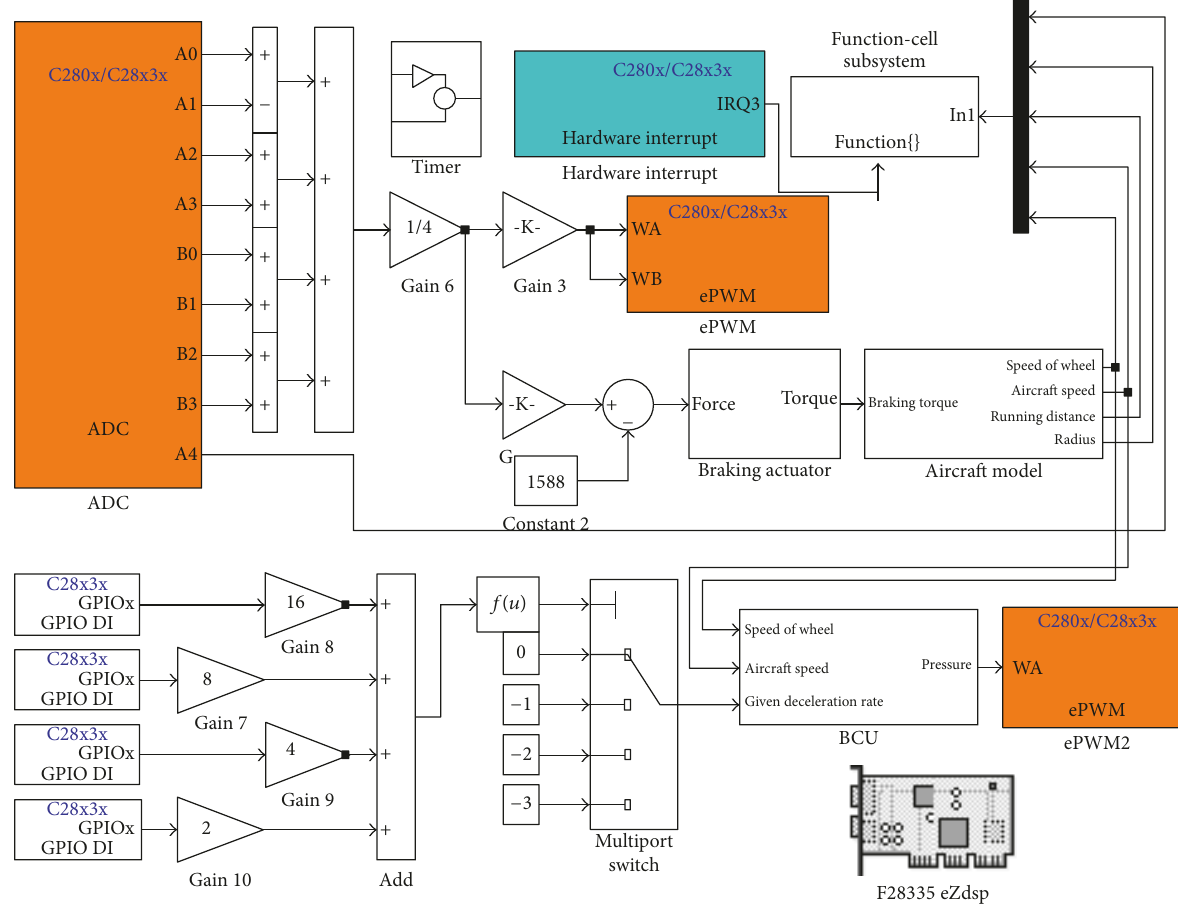
Figure 9: The discrete model of braking